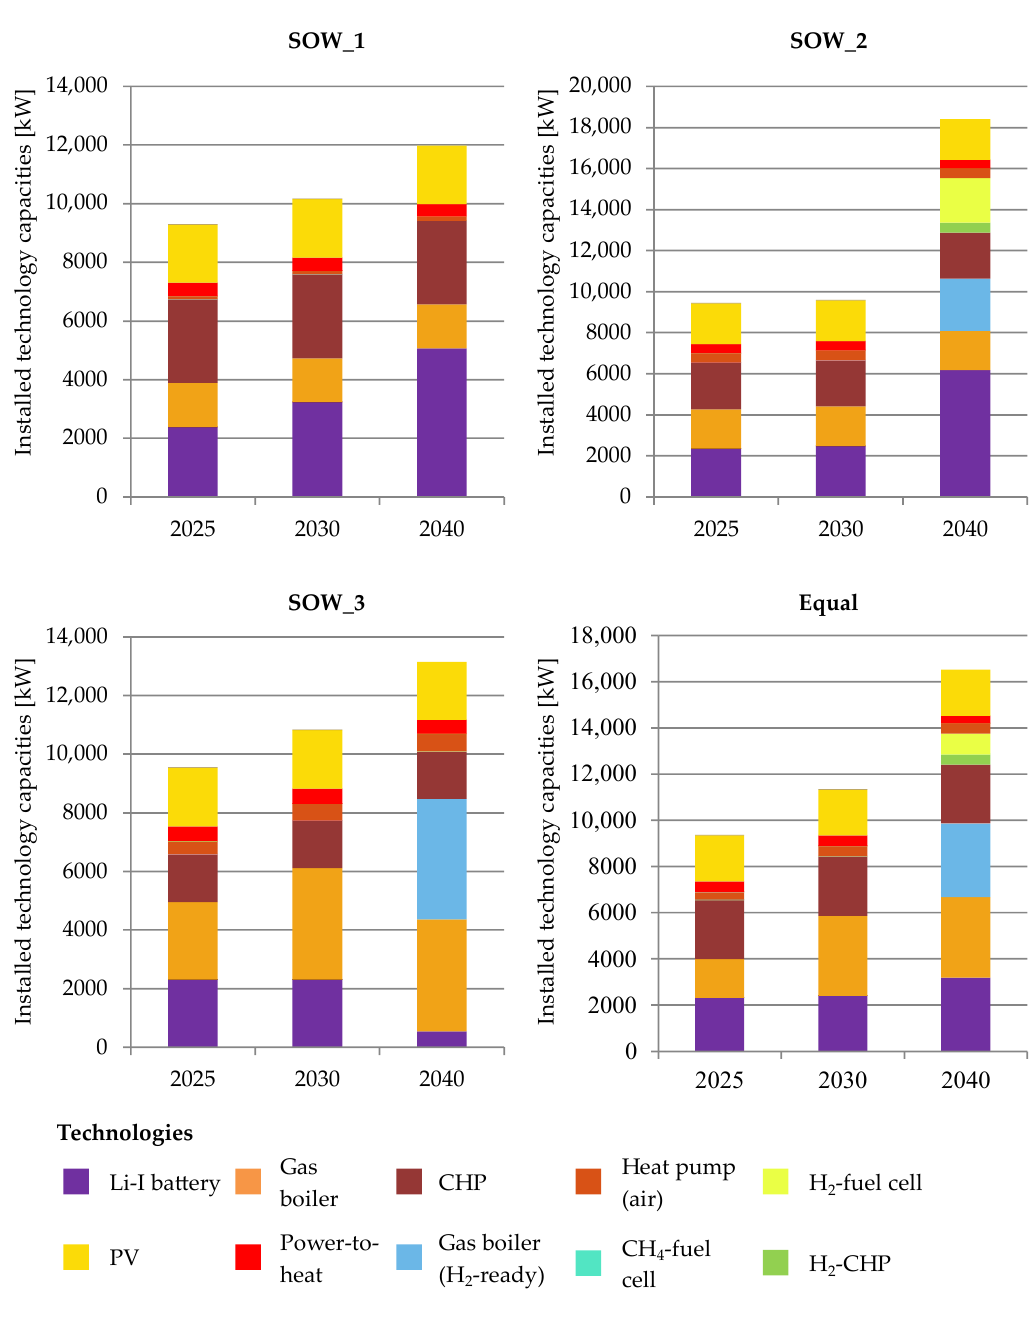
Figure 23. Installed technologies for different scenarios (myopic_years, without CCS).